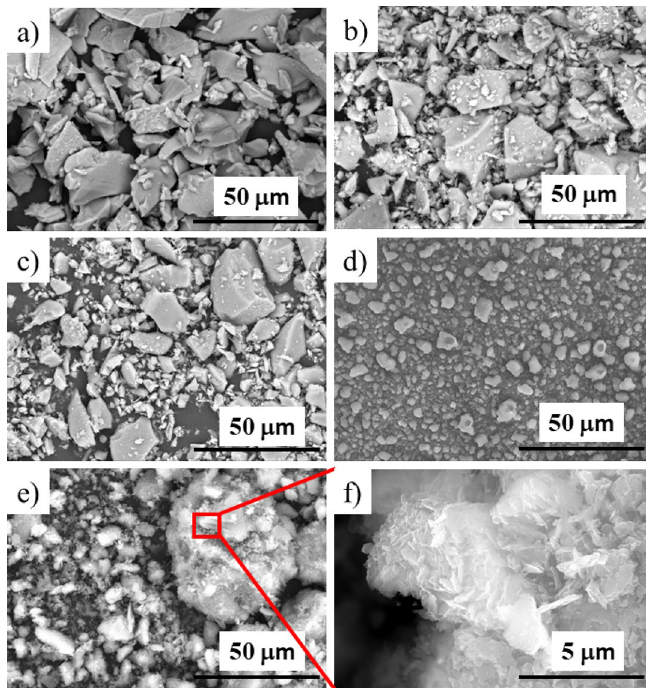
Figure 1. Scanning electron microscopic images of the different types of fillers: ( a ) Al 2 O 3 , ( b ) Fritt1, ( c ) Fritt2, ( d ) MgO, ( e ) and ( f ) natural